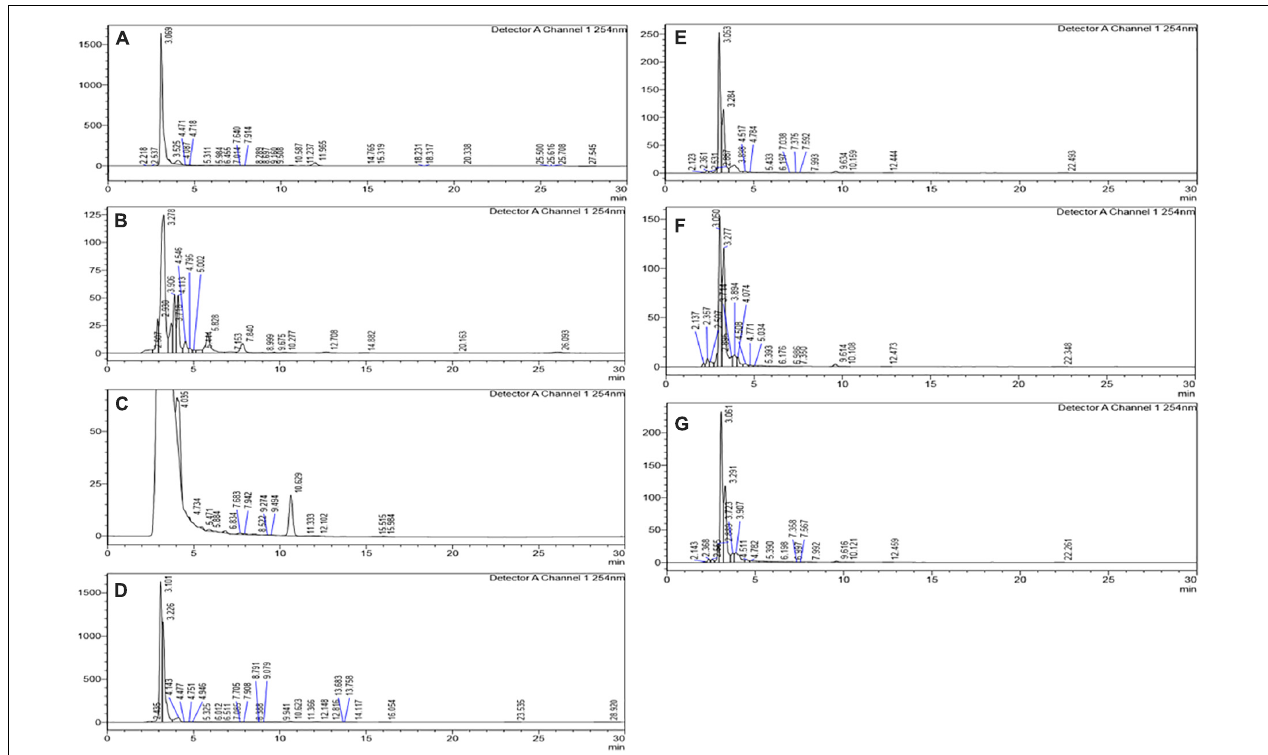
FIGURE 2 | Comparative analysis of the differential HPLC secondary metabolite profiles produced by the strain with and without the epigenetic modifier treatment. Control (A) , 5-azacytidine (B) , Valproic acid (C) , Hydralazine Hydrochloride (D) , Sodium butyrate (E) , Quercetin (F) , and SAHA (G) .